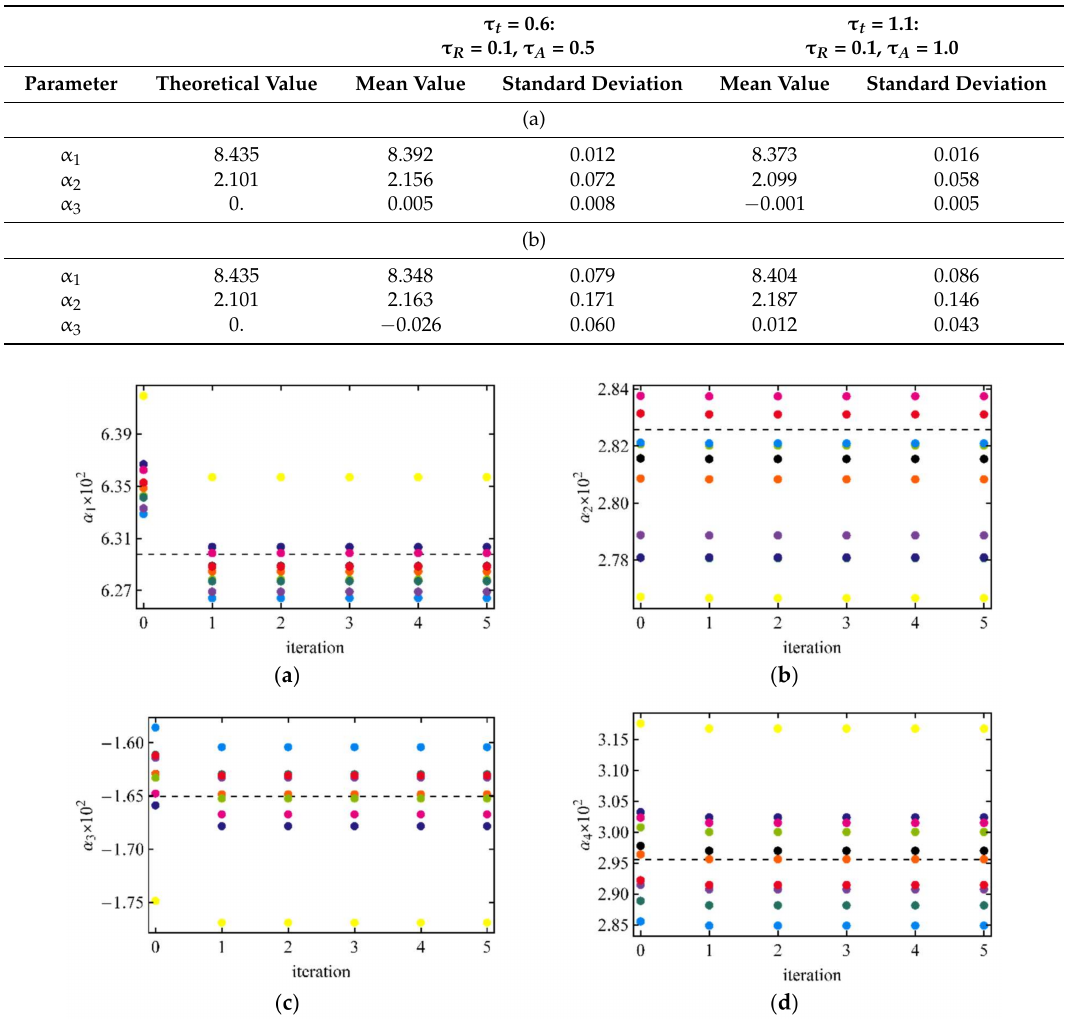
Table 2. Parameters of MODIS BRDF, Equation (14), retrieved from surface radiance using 10 sets of 60 (a), and 10 sets of 12 (b) randomly selected sun-to-sensor geometries for different optical thickness of the atmosphere multiplied by 100.